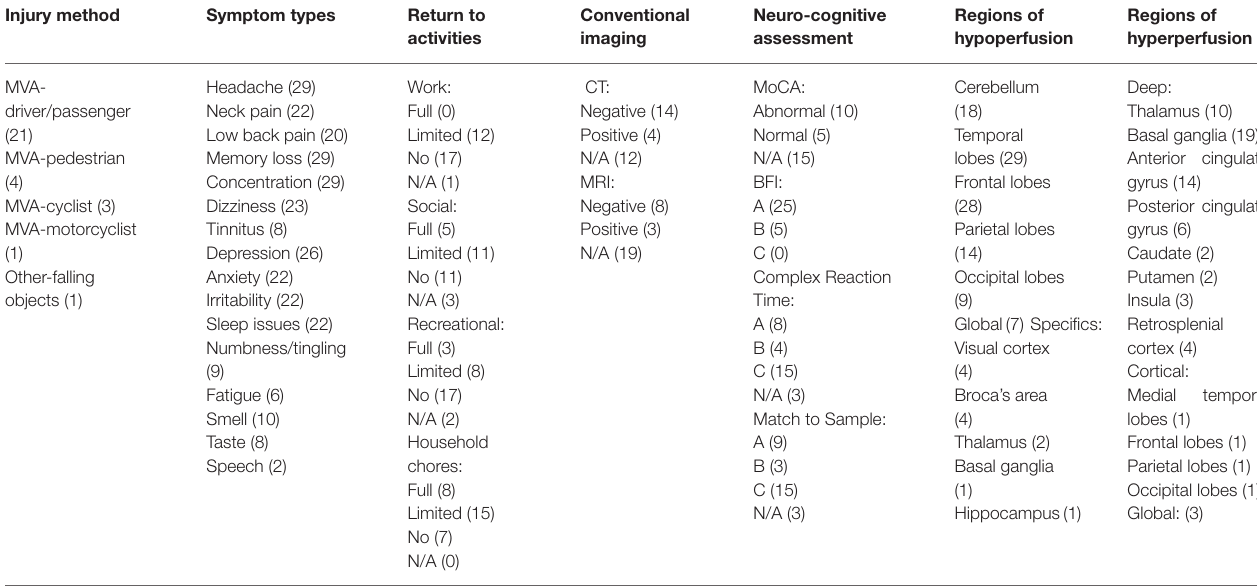
TABLE 1 | Summary of findings and visual single positron emission computed tomography (SPECT)